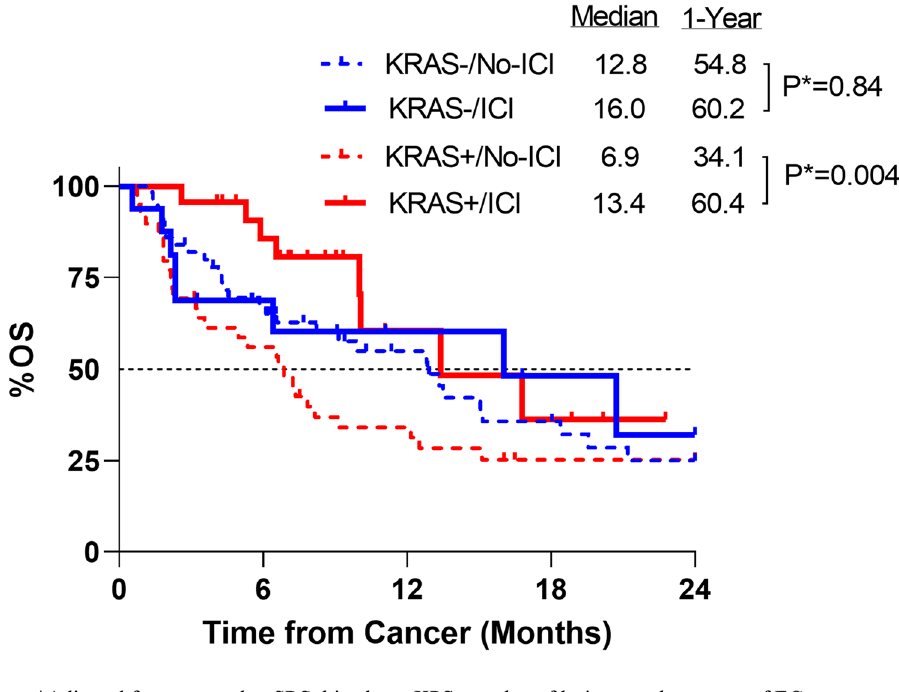
Figure 3. Impact of KRAS status on efficacy of ICI. Overall survival is plotted from the start of ICIs. Multivariate analysis which included age, gender, SRS, histology, KPS, number of lesions and presence of